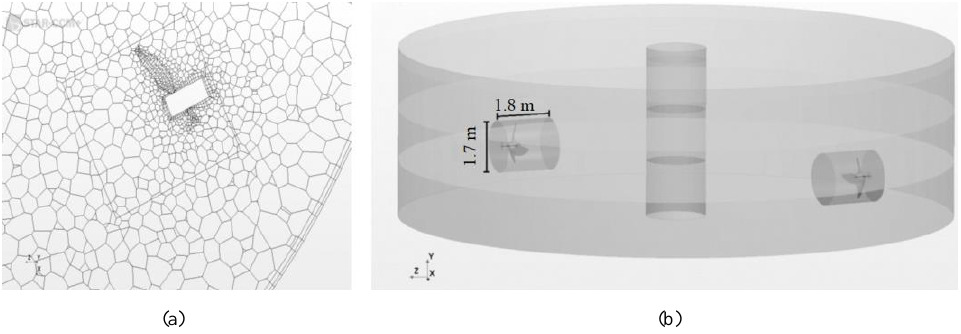
Fig. 4. Geometry of regions and sub-regions imported in the CFD model: (a) mesh around propeller RW; (b) whole digester with the presence of two propeller mixers placed in diametrically opposite positions and in M-2 configuration. In Fig. 5 the flow velocity for the three mixing configuration is